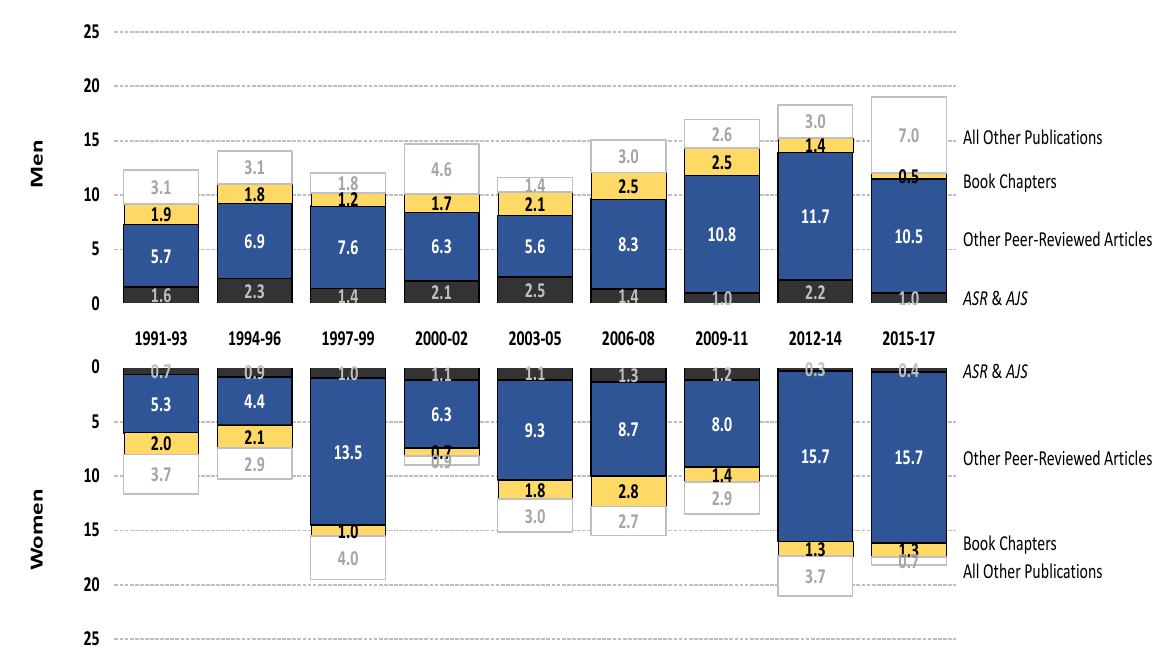
Figure 14: Mean number of publications for newly promoted associate professors who published zero books by type, year, and